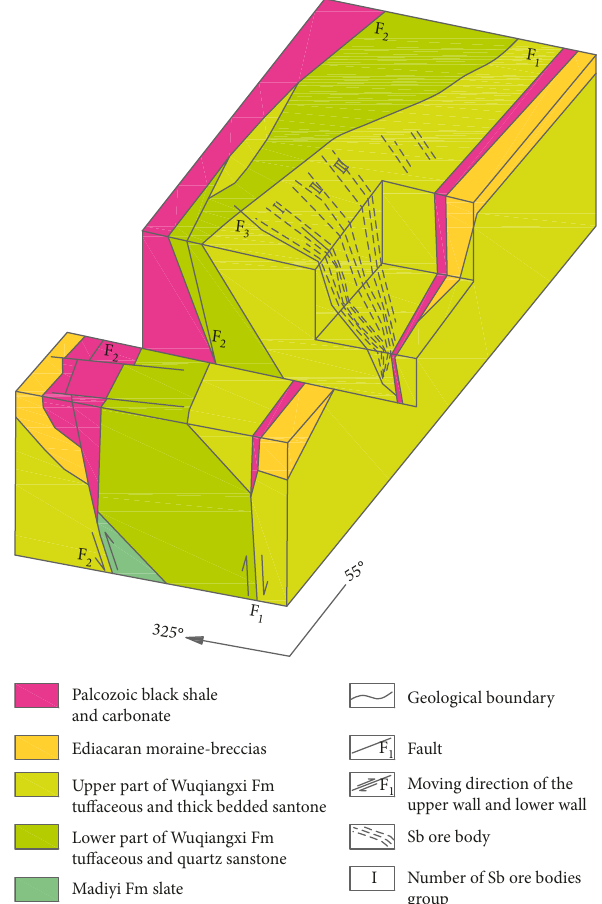
Figure 1: Fault block structure stereogram of Zhazixi Antimony